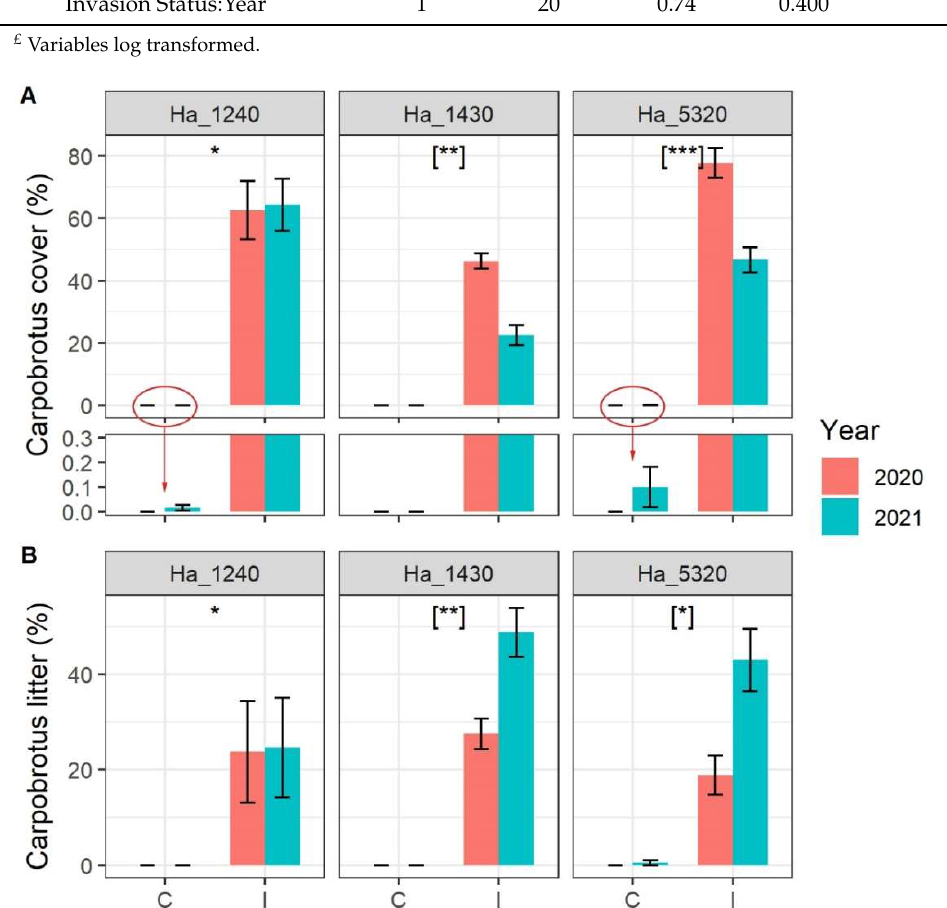
Figure 1. Cover of ( A ) Carpobrotus spp. and ( B ) Carpobrotus spp. dead litter in the sampled plot according to N2000 habitat, status of invasion (C = Control plots, I = Invaded plots) and year. N2000 habitat codes: 1240 = vegetated sea cliffs of the Mediterranean coasts with endemic Limonium